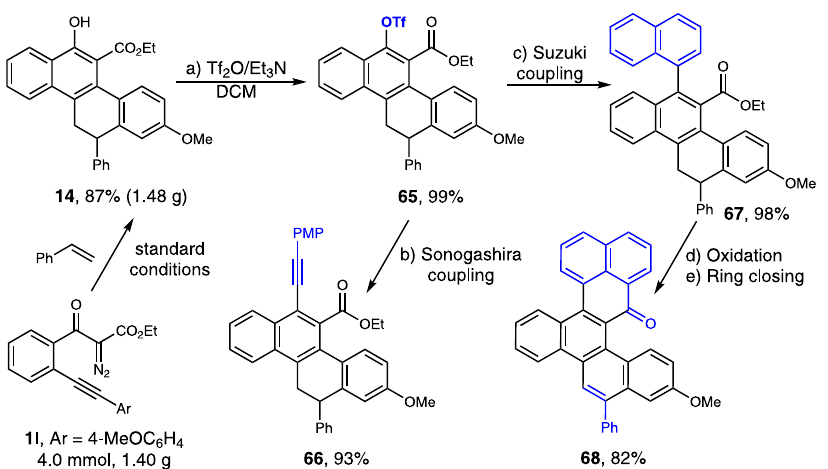
Fig. 9 Synthetic transformations. The product 14 was prepared on a 4.0 mmol scale under optimal conditions. a Sulfonylation of the phenolic hydroxyl group. b Sonogashira coupling. c Suzuki coupling. d Oxidation. e